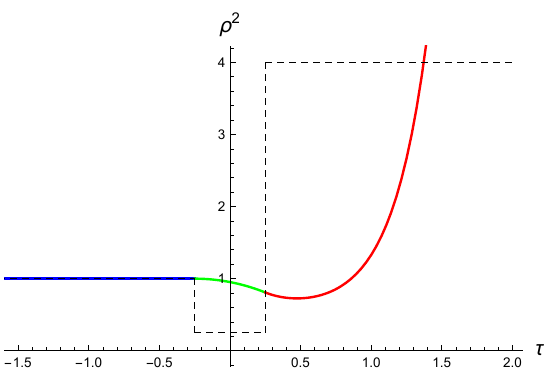
Figure 4. A non-monotonic (cid:26) 2 ( (cid:28) ) for an abrupt dip pro(cid:12)le with ! 0 = 1 ; ! 2 = 1 = 2 and ! 1 = 2 with T = 1 = 2. The dashed line is the pro(cid:12)le of f ( (cid:28) ) 2